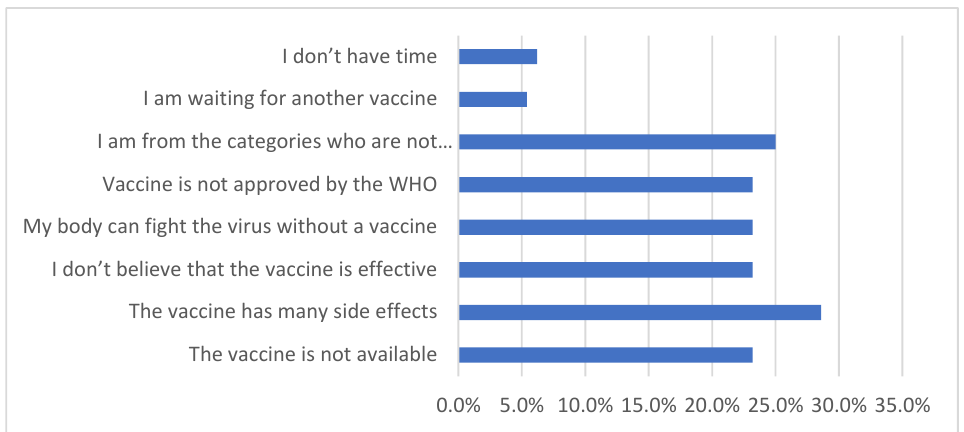
Figure 2. Barriers to receive COVID-19 vaccine in vaccine non-recipients (n = 56).